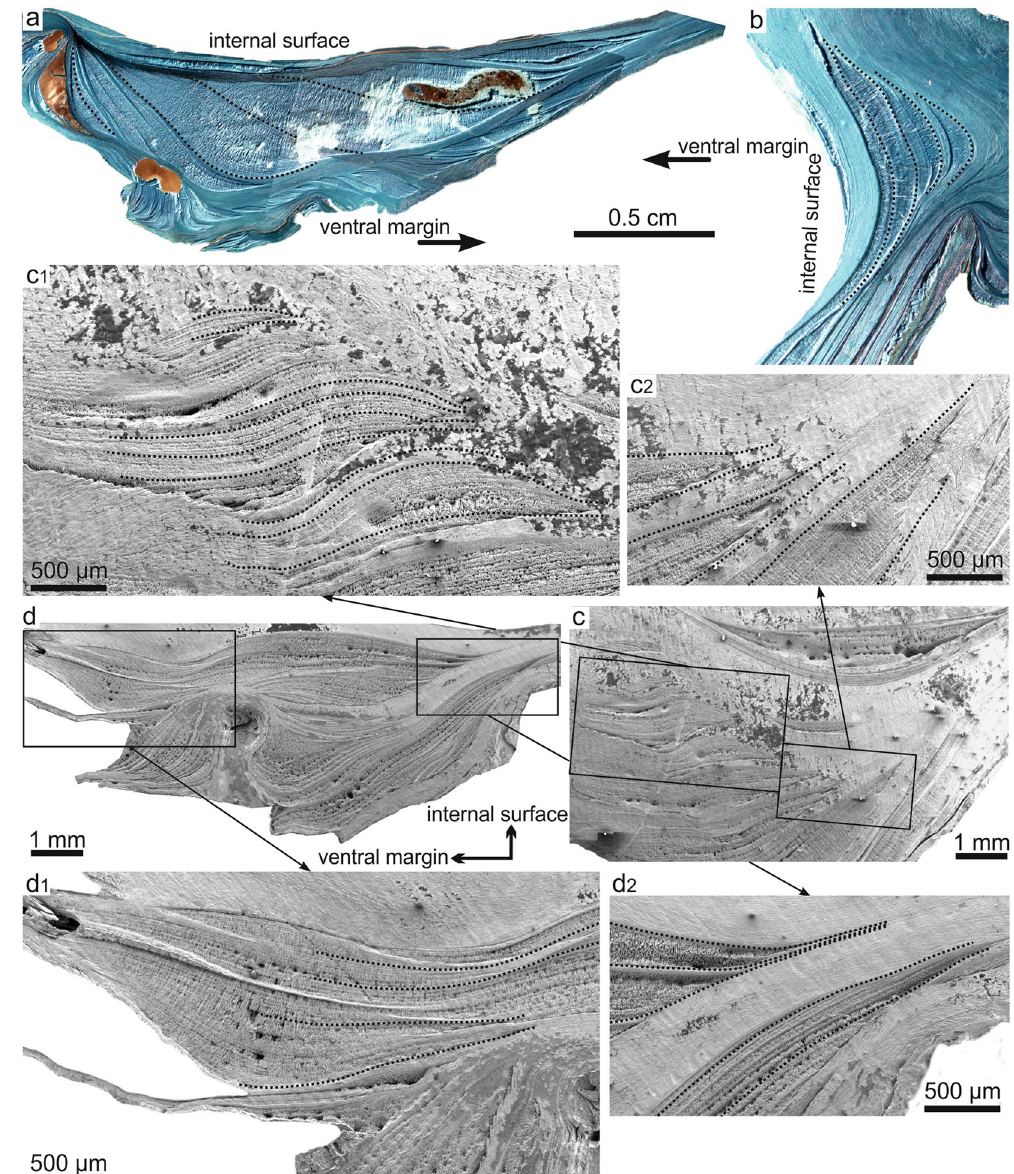
Figure 2. Polished and etched cross sections of left valves of M . angulata . ( a , b ) Composite optical micrographs of specimens treated with Mutvei’s solution. ( a ) Central part of a left valve. ( b ) Umbonal cavity of left valve. ( c , d ) SEM wide scope views of polished and etched specimens. ( c ) Central area. ( d ) Ventral area. c1, c2, d1 and d2 are close-up views of the areas framed in ( c , d ). Treatments reveal the outlines of chalk lenses, as well as the distribution of growth lines. Some growth lines have been outlined in order to show their continuity and the increase in spacing of the growth lines from the foliated material to the